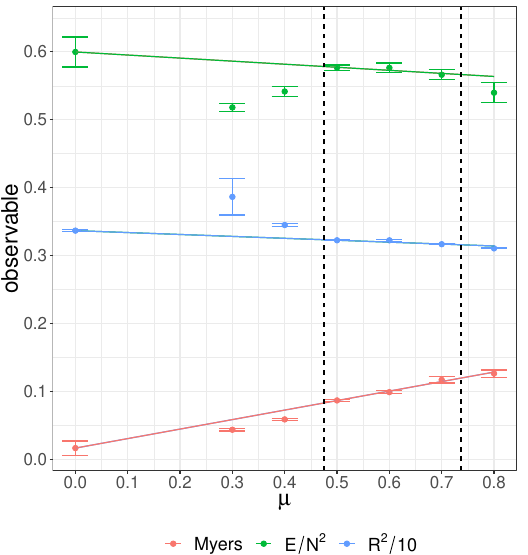
Figure 9 . The expectation values of a few observables at T = 0 . 3 , N = 16 , L = 24 are plotted against µ . Above and below µ = 0 . 5 , the behavior of R 2 is different. A quick increase of R 2 at µ < 0 . 5 is associated with instability associated with the flat direction in the BFSS limit. Other observables change the behavior, too, once the instability sets in. The data points at µ = 0 are the linear extrapolations for values of µ in 0 . 5 ≤ µ ≤ 0 . 7 . The linear extrapolations are only used to indicate, in accordance with figure 8, that we see a negligible slope for E as well as to highlight the diverging behavior for µ < 0 . 5 that sets in at lower temperatures. The µ → 0 limit was studied in a different setting in ref. [22] and a quadratic extrapolation was used for observables such as E/N 2 and R 2 /N 2 , however, we are agnostic about odd or even preference of the µ